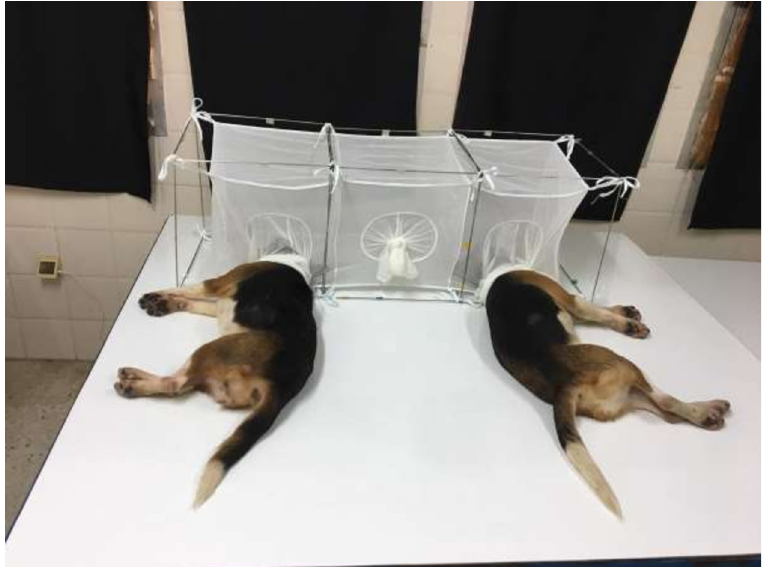
Fig 1. Host attractiveness experiment in the